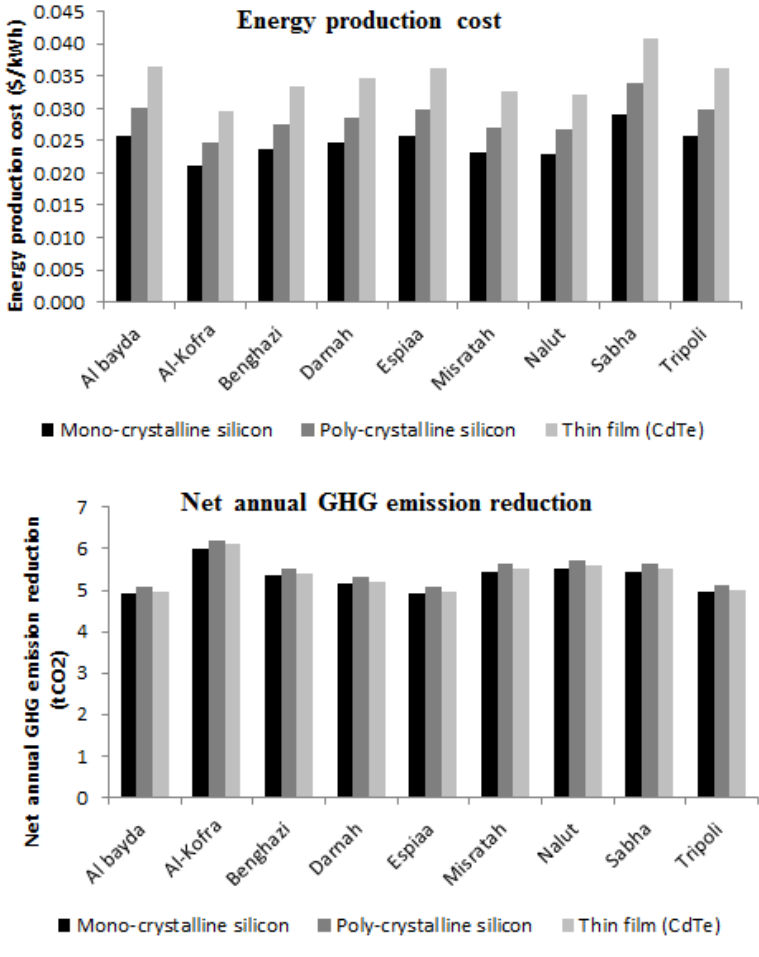
Figure 8. Sensitivity analysis for the 5kW grid-connected solar PV